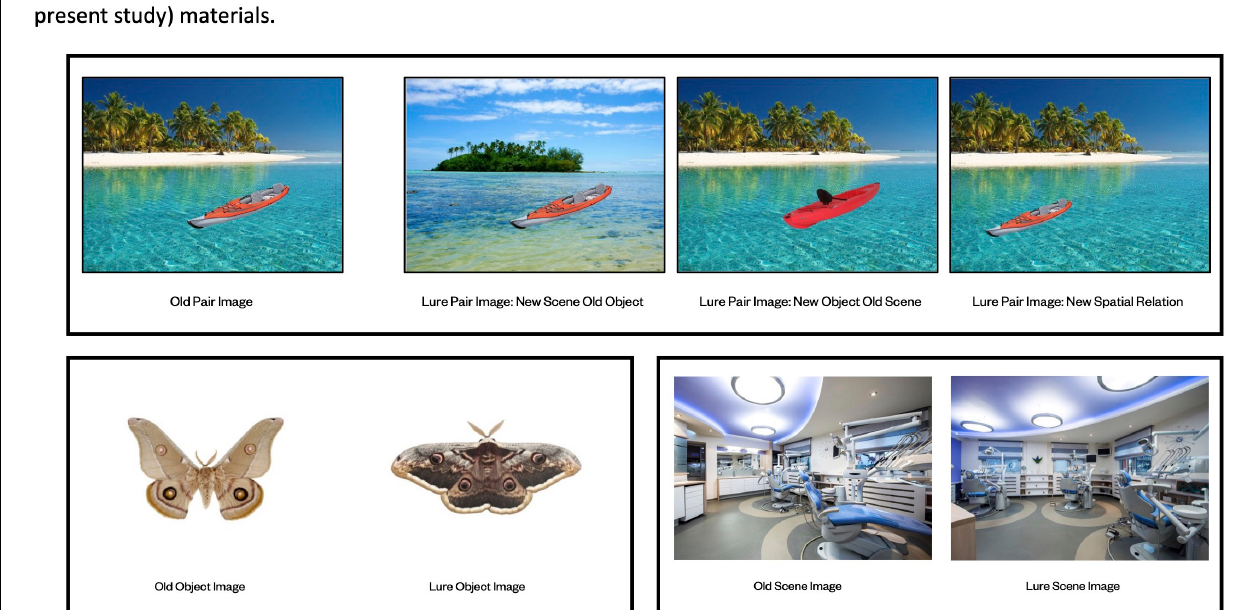
Frontiers in Aging Neuroscience |